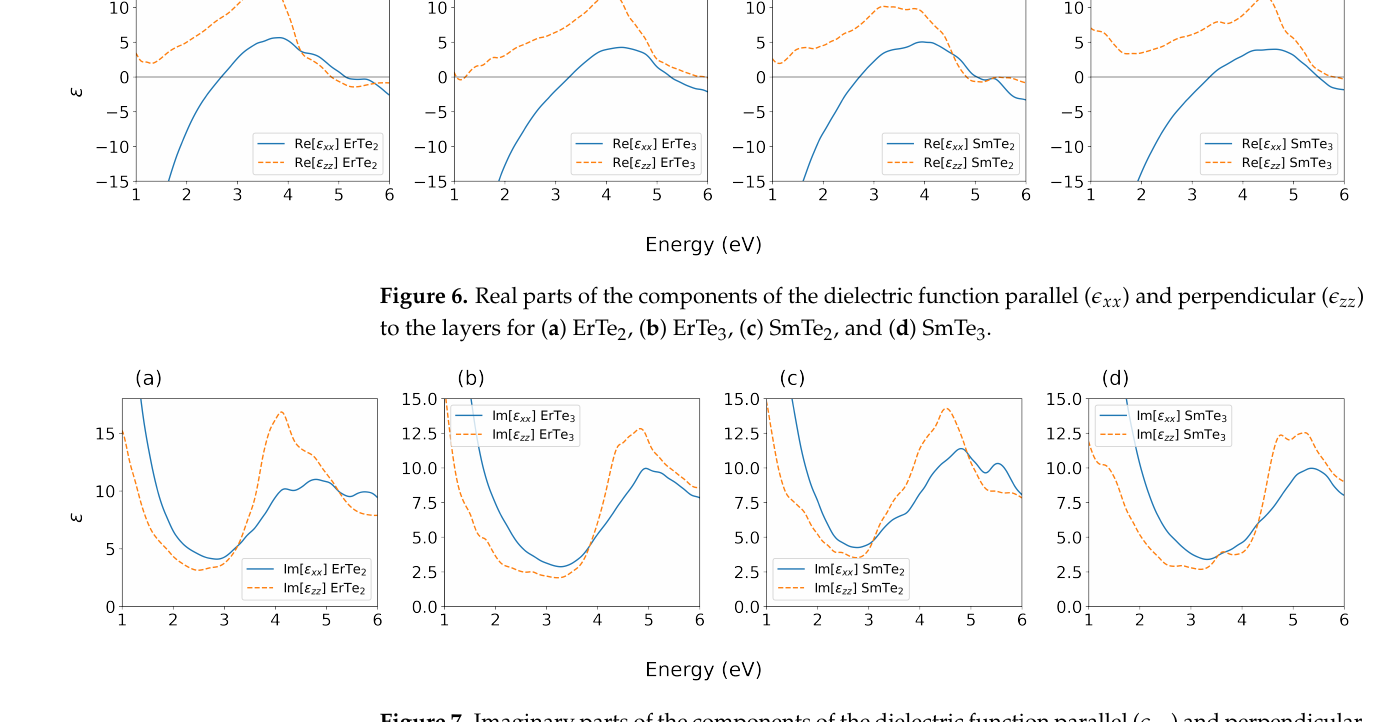
Figure 7. Imaginary parts of the components of the dielectric function parallel ( (cid:101) xx ) and perpendicular ( (cid:101) zz ) to the layers for ( a ) ErTe 2 , ( b ) ErTe 3 , ( c ) SmTe 2 , and ( d ) SmTe 3